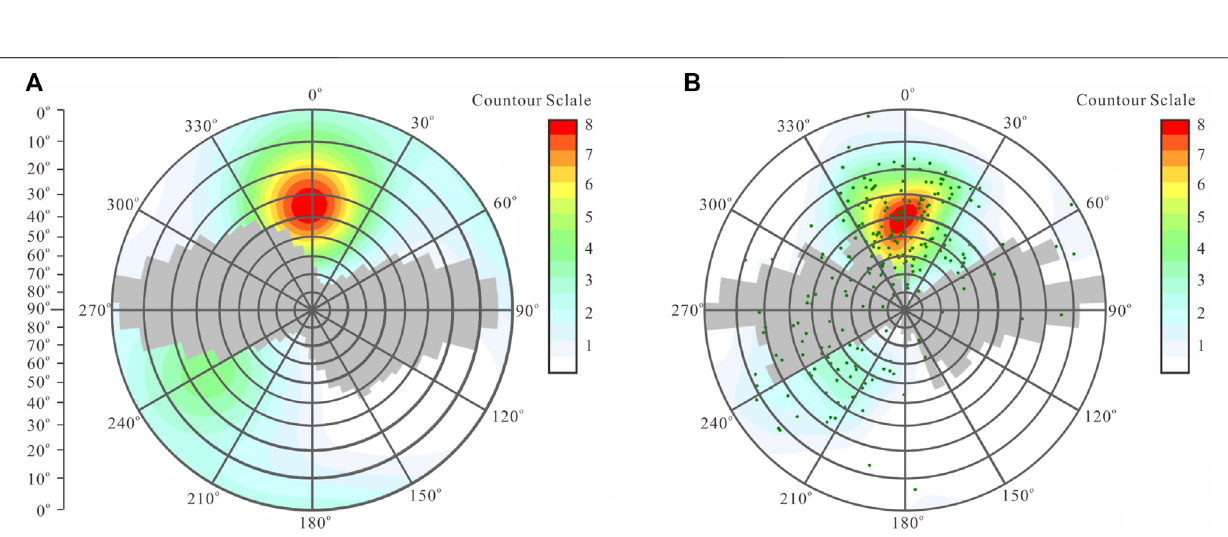
Frontiers in Earth Science |